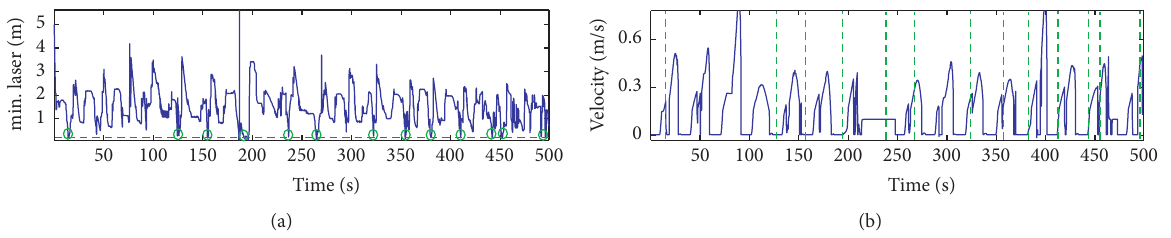
Figure 5: (a) Minimum distance measured by the laser mounted on the robot (blue line); red dashed line identifies 0.25 m and green circles represent situations in which collisions occurred. (b) Reference velocity generated by the Timing Control (blue line) and vertical dashed green lines indicating the